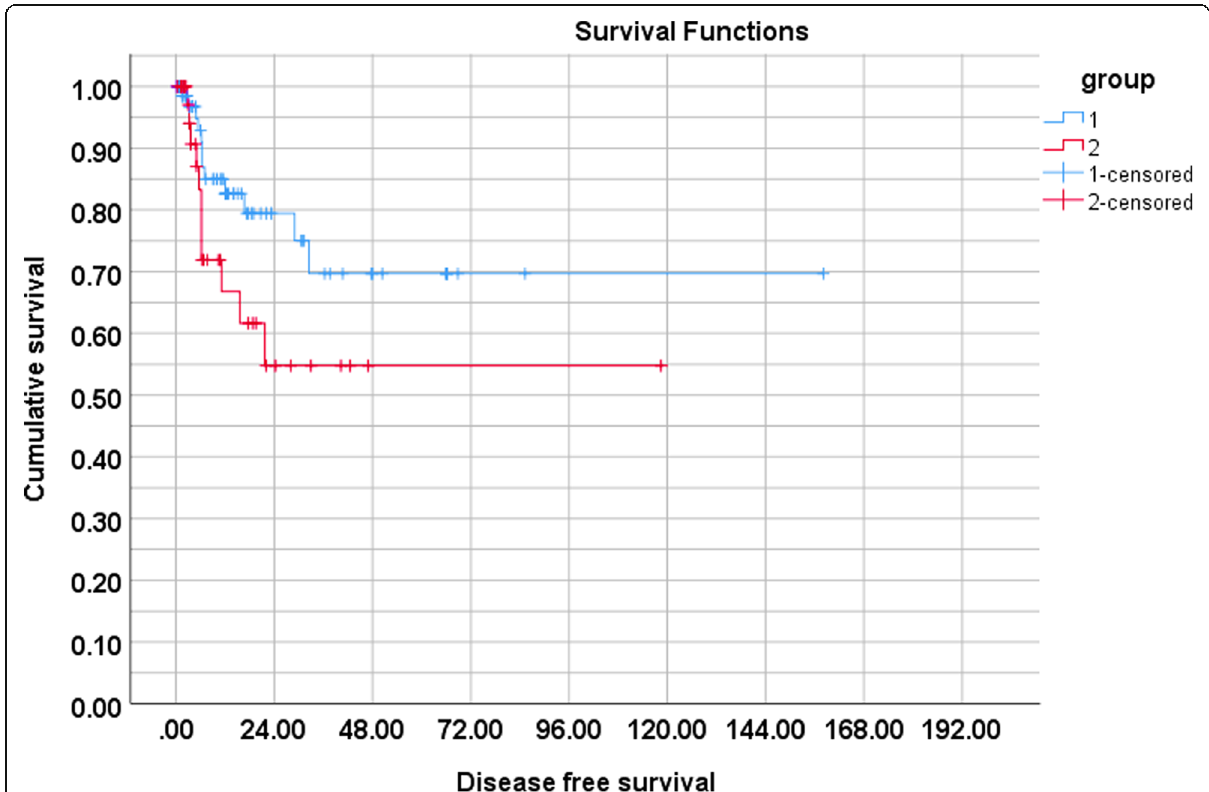
Fig. 2 Disease-free survival by Kaplan-Meier survival curve in ALL patients treated with either TBI/Cy (group 1) or Bu/Cy (group